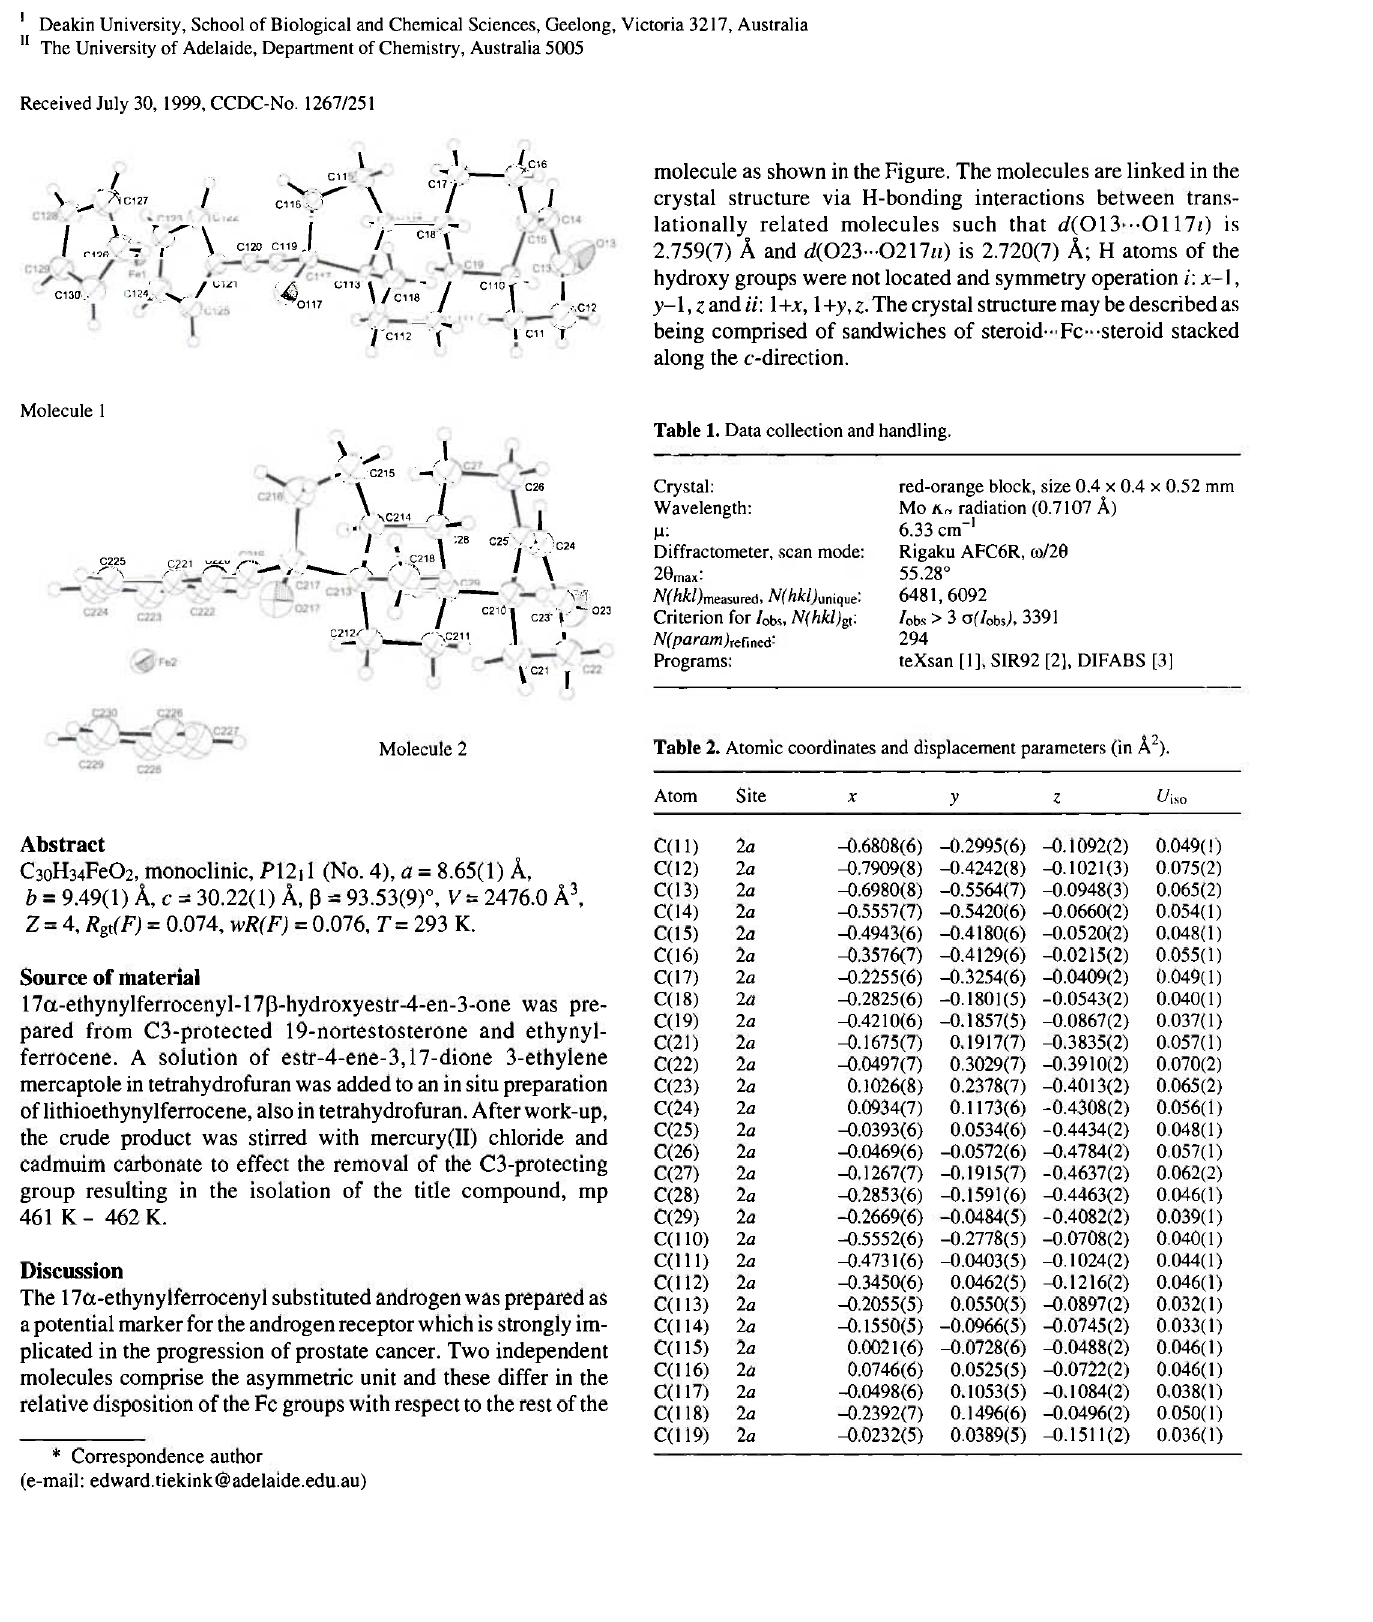
Table 1. Data collection and handling.